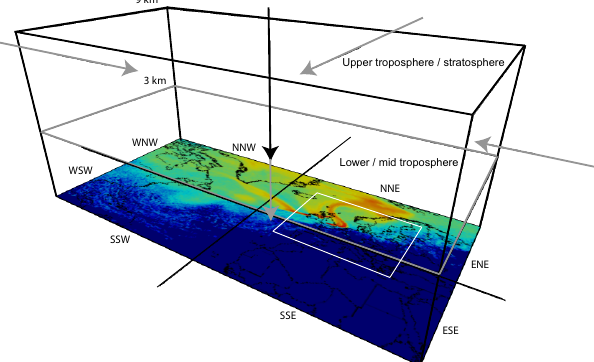
Figure 2. Schematic of boundary conditions (BCs) estimated as part of the inversion. The inversion domain is represented by the inner white box. The map shows combined air histories for all four sites at a given instance and illustrates that the stations can sam- ple different “baselines” at the same time due to differences in their meteorology. PDF parameters to 17 BCs were estimated in total; eight defining the polynomial that governs the WSW boundary and offsets for seven other horizontal boundaries and two upper atmo- sphere boundaries (arrows in grey correspond to the BC governing air entering the 3–9km box and the arrow in black corresponds to the BC governing air from above